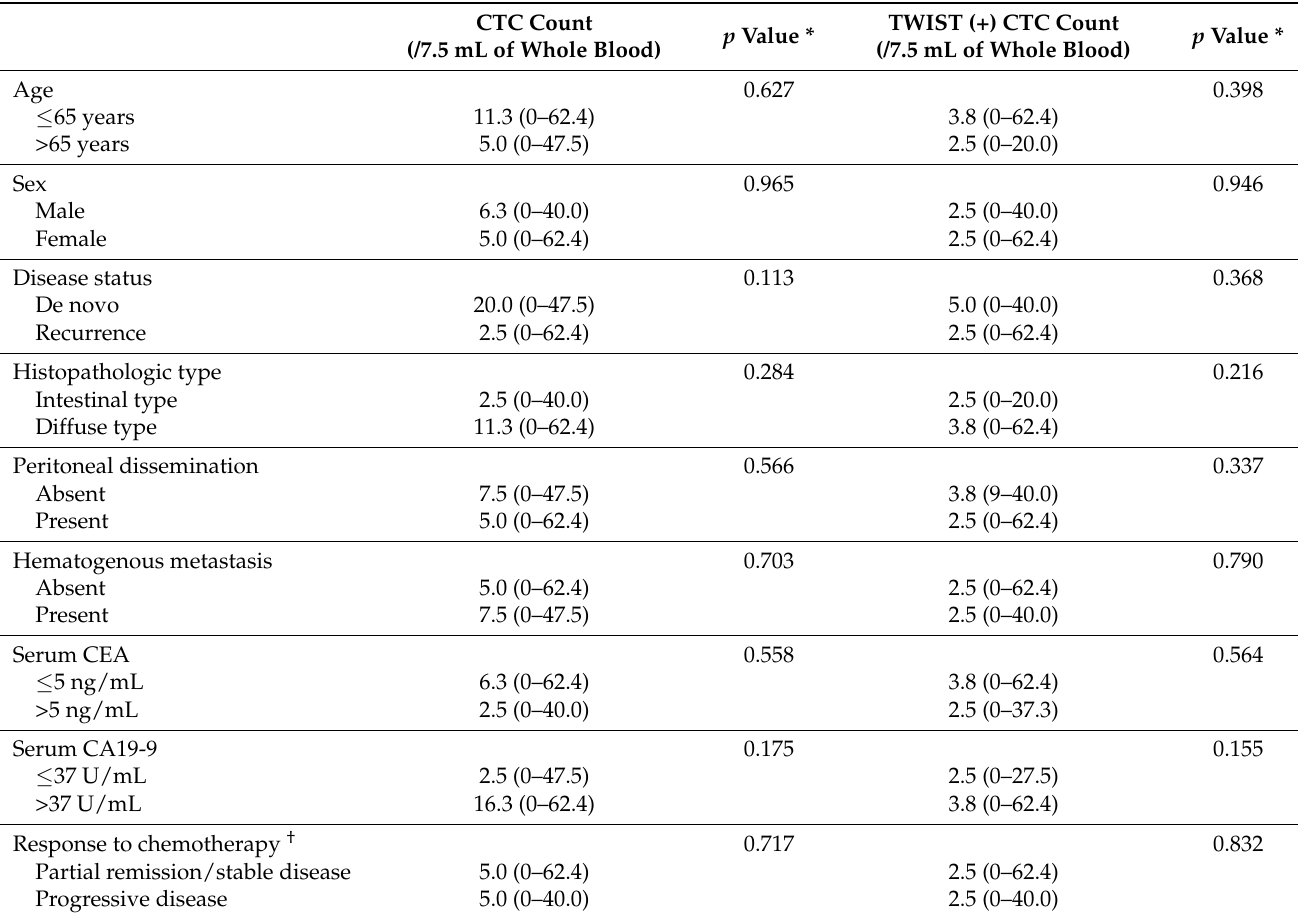
Table 2. Circulating tumor cell (CTC) and TWIST (+) CTC counts according to the clinicopathologic characteristics of 31 patients with metastatic gastric cancer.